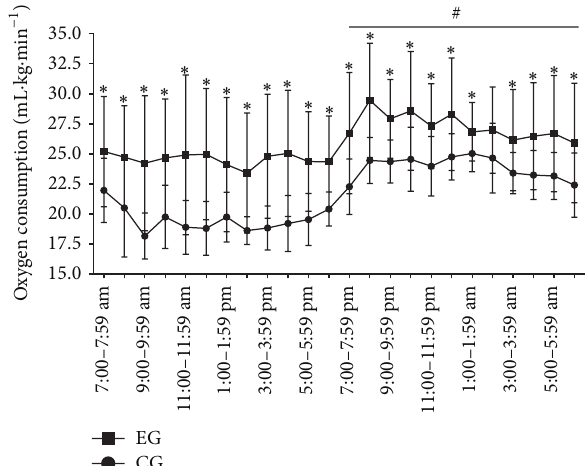
Figure 2: Oxygen consumption for 24 hours after the end of SD. (- ◼ -) Experimental group (EG) and (- e -) control group (CG). The horizontalblacklineshowsthedarkperiod(7:00pm–6:59am).Data are shown as the mean ± standard deviation; statistical significance was accepted at 𝑃 < 0.05 ; ( ∗ ) difference between the CG at EG at each time point, ( # ) mean different between light and dark periods within each